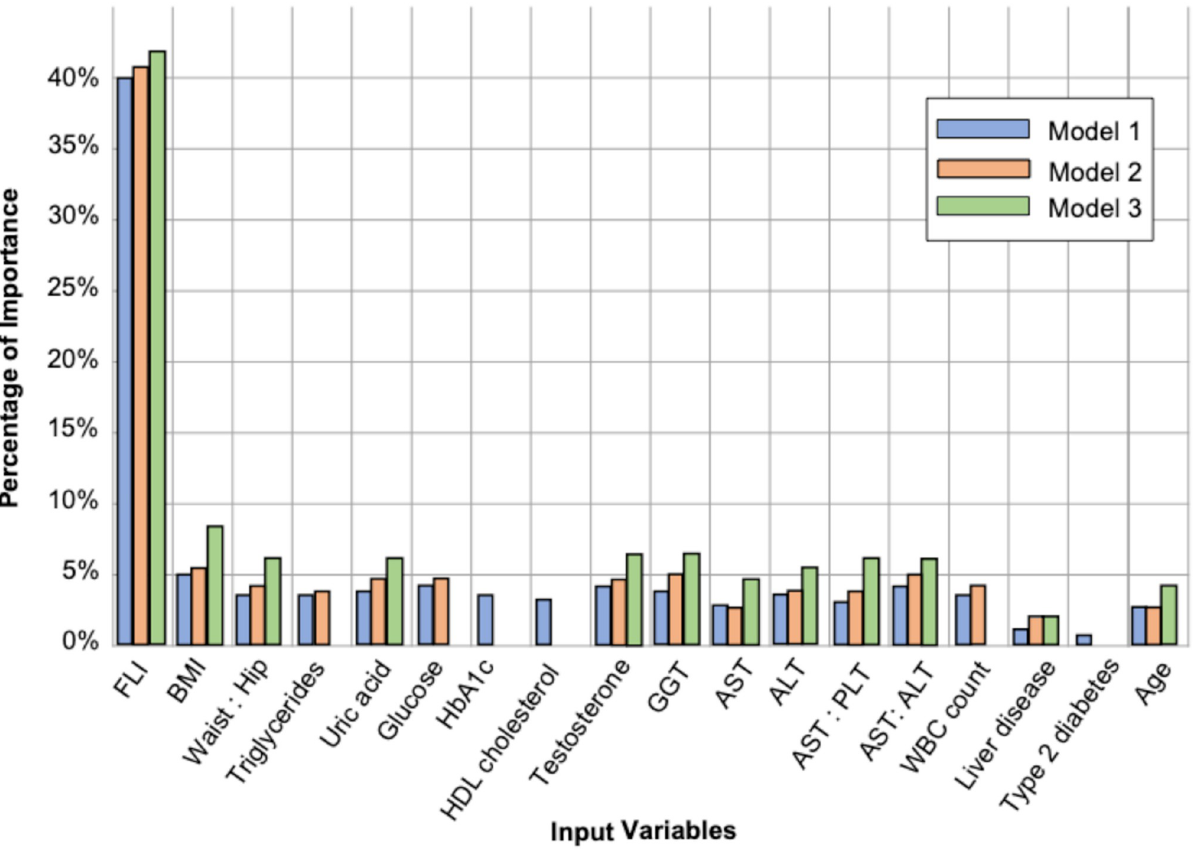
Fig 3. Input variable importance in the three models.